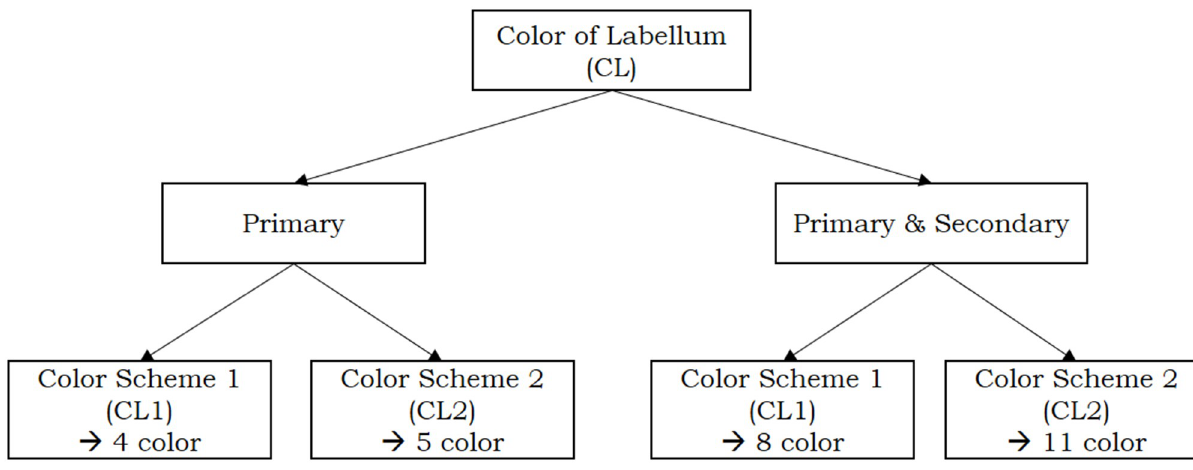
Fig 5. Scenarios for Color of Labellum